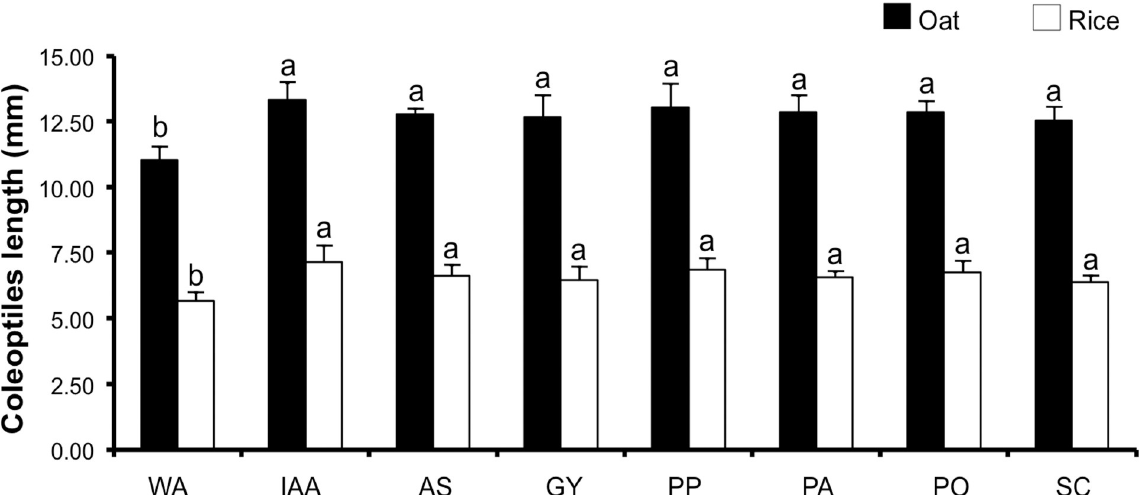
Fig 6. Coleoptile elongation of oat and rice. WA = distilled water treatment, IAA = IAA standard treatment, AS = crude culture extract of Astraeus odoratus treatment, GY = crude culture extract of Gyrodon suthepensis treatment, PP = crude culture extract of Phlebopus portentosus treatment, PA = crude IAA of Pisolithus albus treatment, PO = crude culture extract of Pisolithus orientalis treatment and SC = crude culture extract of Scleroderma suthepense treatment. The results are means of five replicates ± SD. Different letters above each graph indicate the significant difference ( P < 0.05).